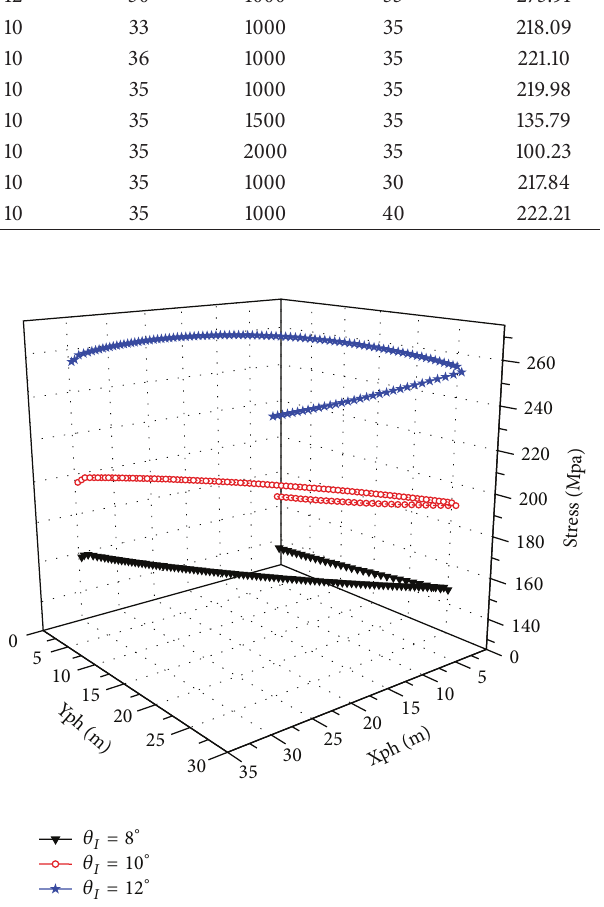
Figure 9: Maximum stresses in different 𝜃 𝐼 .